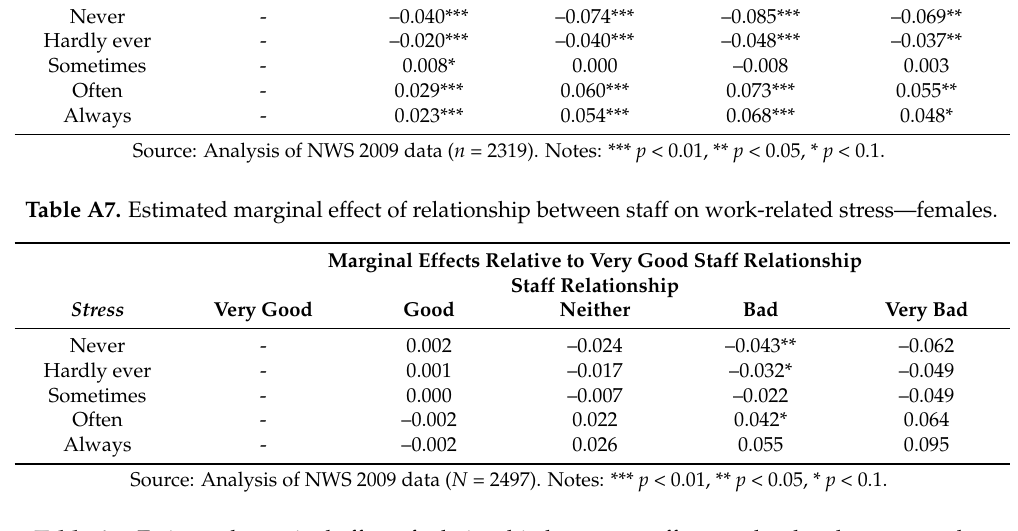
Table A8. Estimated marginal effect of relationship between staff on work-related